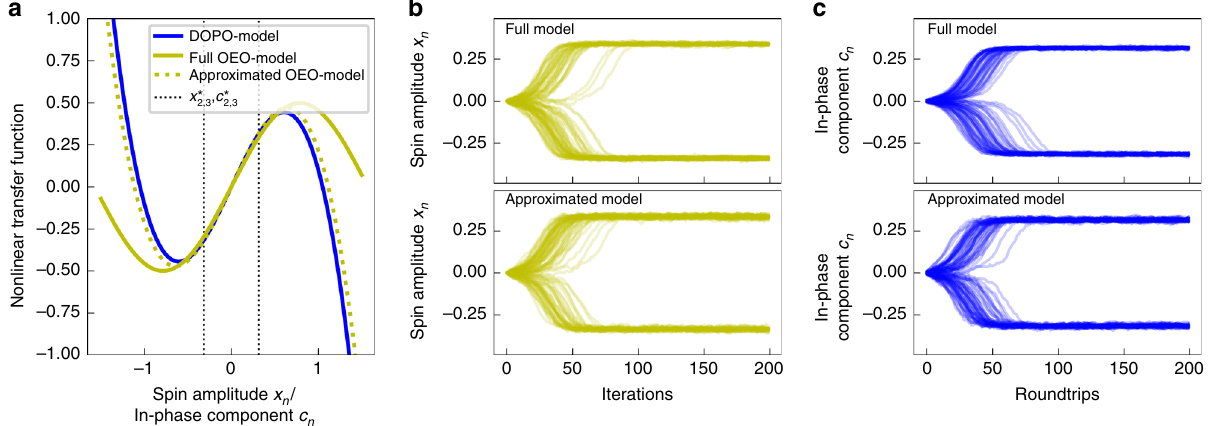
Fig. 6 Comparison of dynamics of DOPO-based and OEO-based CIM. a Nonlinear transfer functions for the DOPO-model (blue line), the full OEO model (solid yellow line), and the approximated OEO model (dashed yellow line) at α = p = 1.1. The fi xed points of the models are indicated by the black dashed line. b , c Simulation of the dynamics of 100 uncoupled oscillators for the OEO model ( b ) and the DOPO-model ( c ) at α = p = 1.1. The upper panels show the simulations using the full model, while the lower panels show the results of the approximated